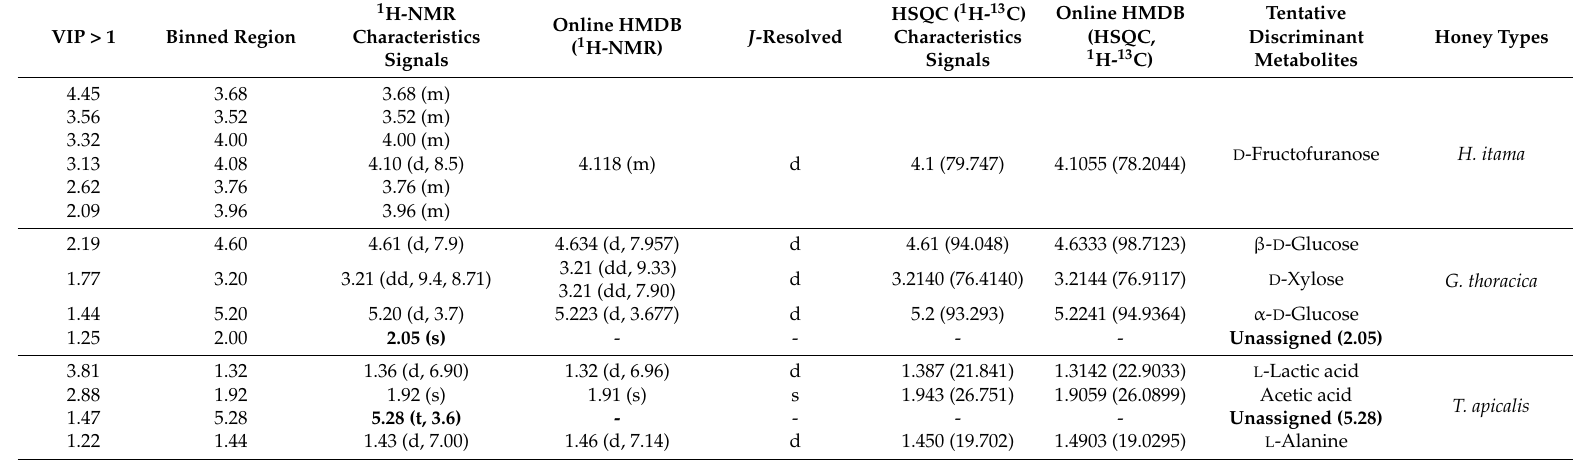
Table 3. List of tentative discriminant metabolites (chemical markers) based on 1 H-NMR spectral data for each types of stingless bee